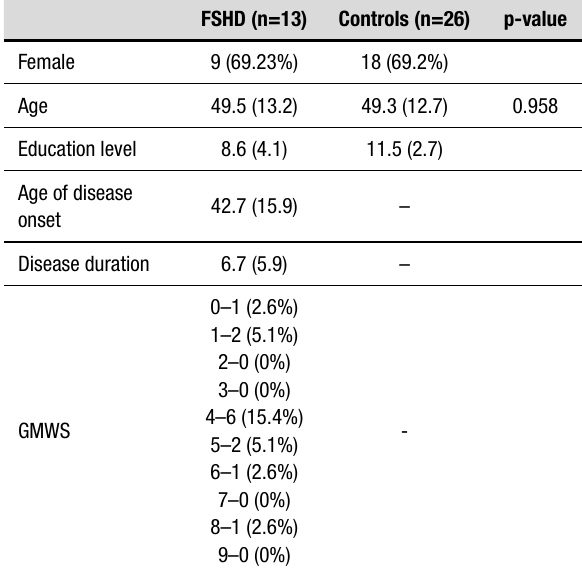
Table 1. Demographic data of the facioscapulohumeral muscular dystrophy and control